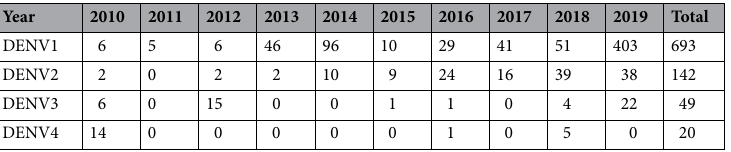
Table 3. Annual numbers of sequences of each dengue virus serotype isolated in Guangzhou between 2010 and